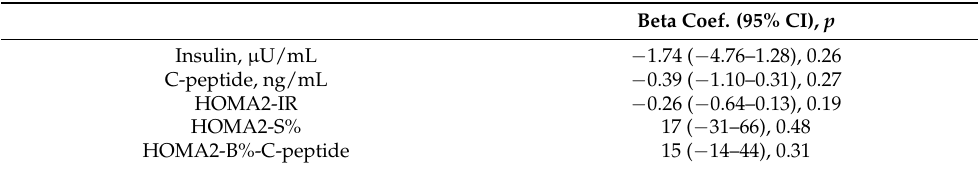
Table 2. Multivariable regression analysis of the differences between controls and patients in terms of glucose homeostasis molecules and IR indexes.